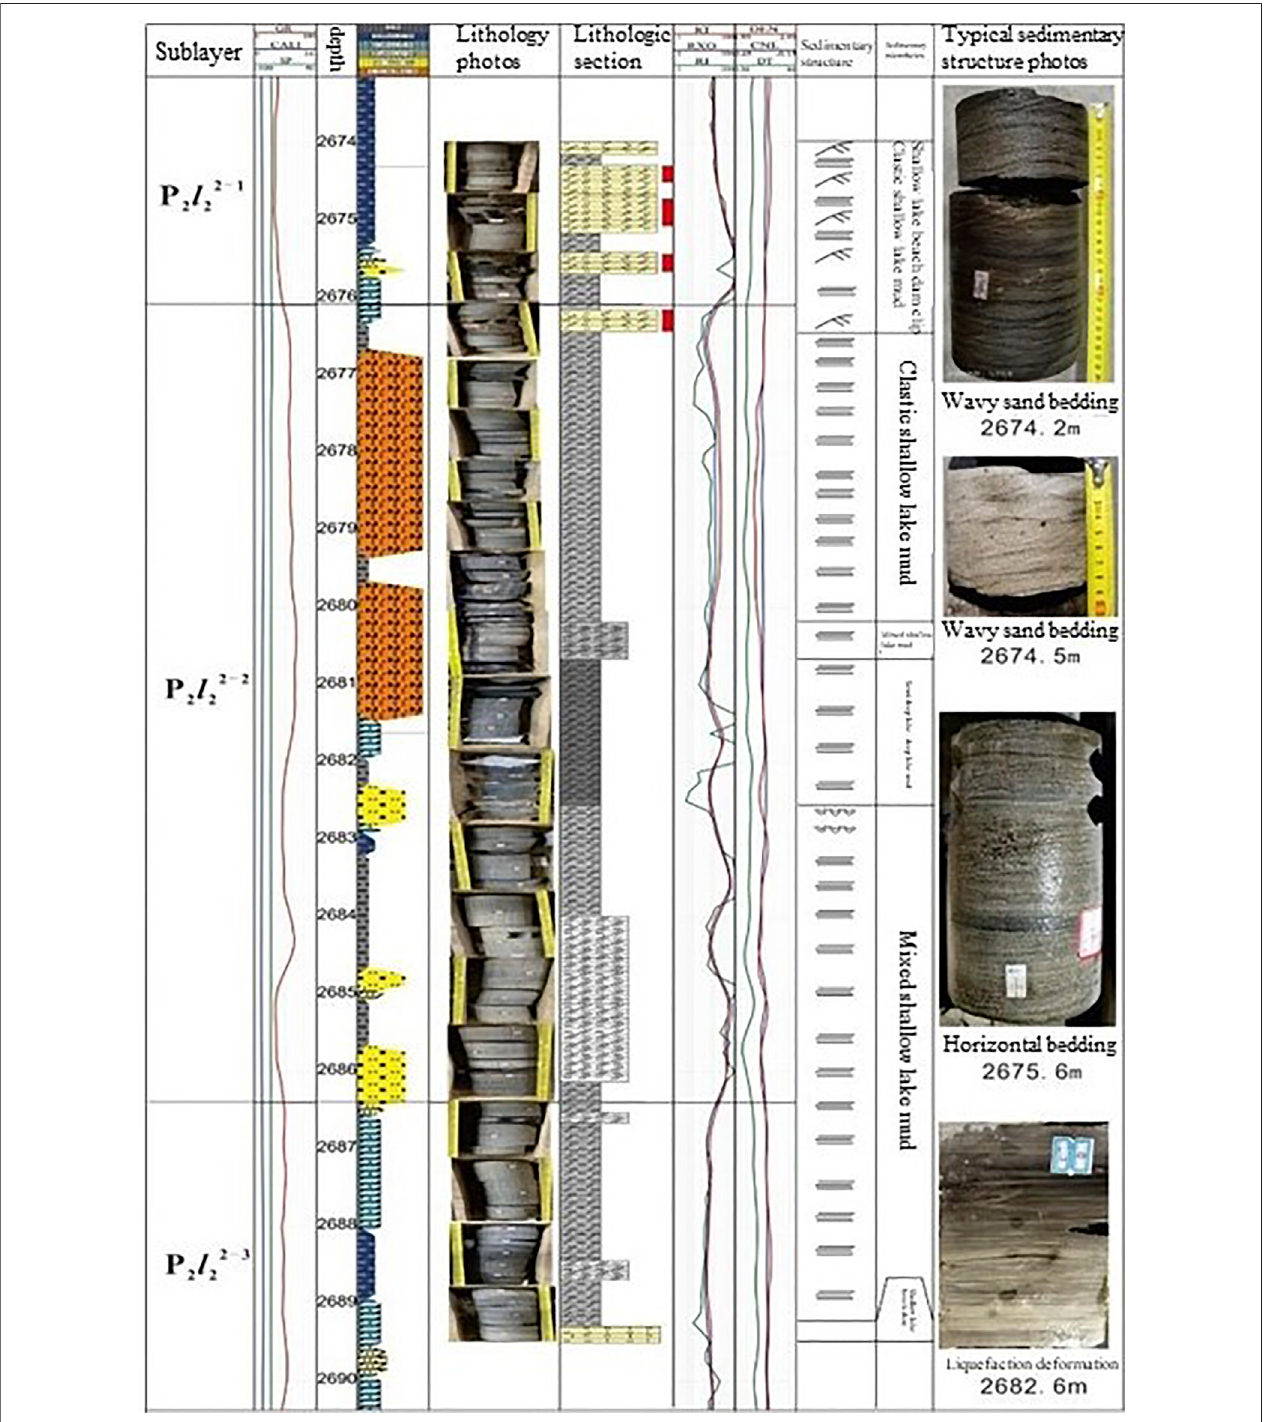
FIGURE 3 | Schematic diagram of sedimentary microfacies with respect to the core of upper sweet spot in J10005 Well of the Lucaogou Formation in the Jimsar Sag.